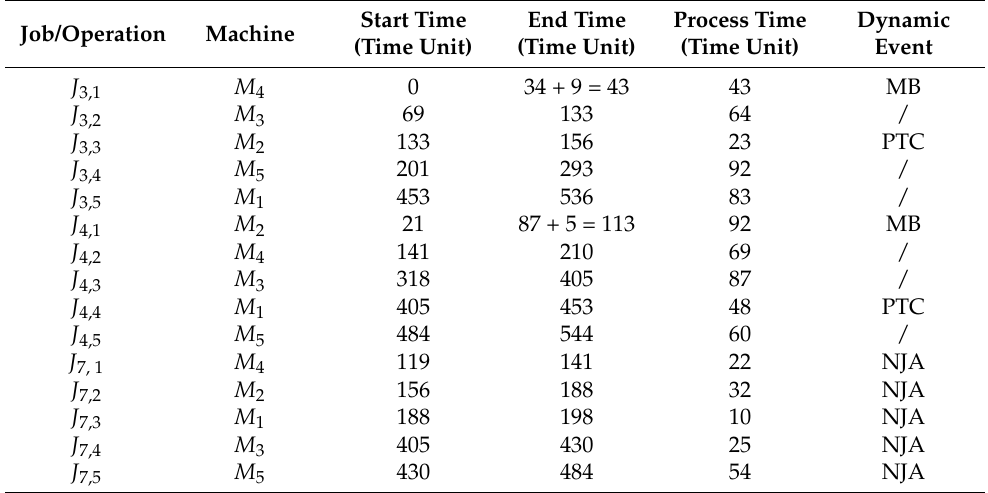
Table 3. The scheduling DJSSP